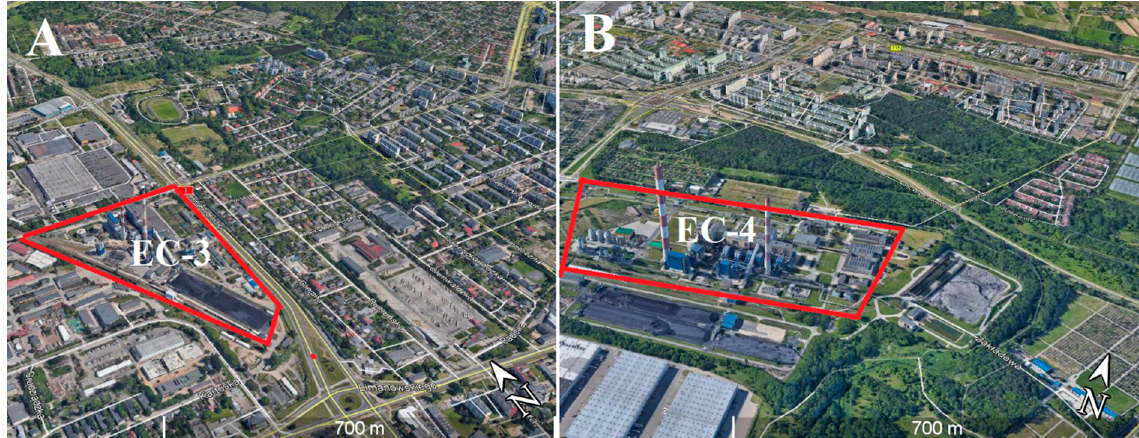
Figure 2. Location and immediate surroundings of the heat and power plant EC-3 ( A ) and EC-4 ( B ) (photo background source: Google Earth Pro).